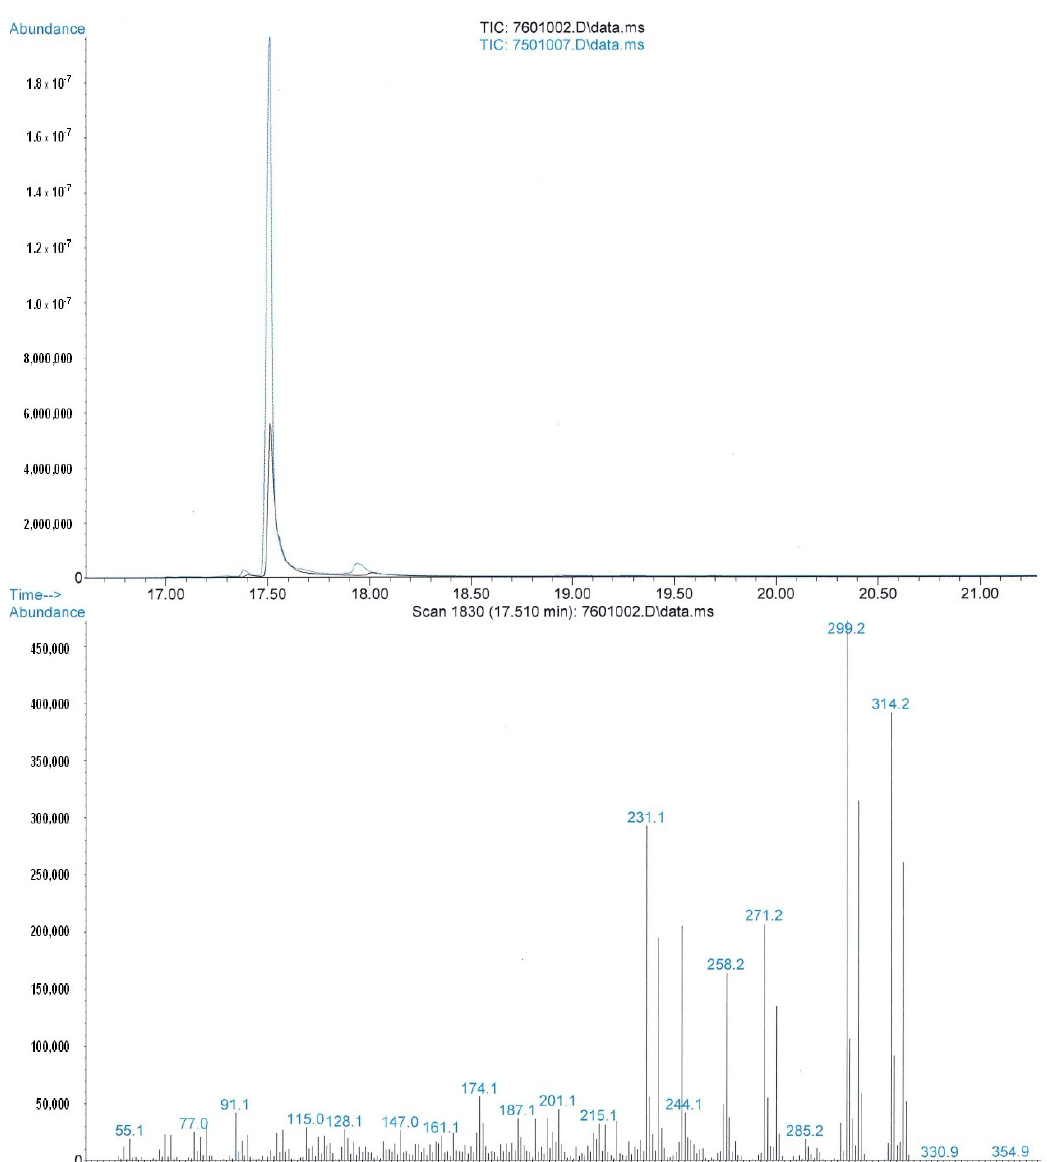
Figure 1. Comparison of GC elution and the total ion chromatograms of [ 13 C and native Δ 9